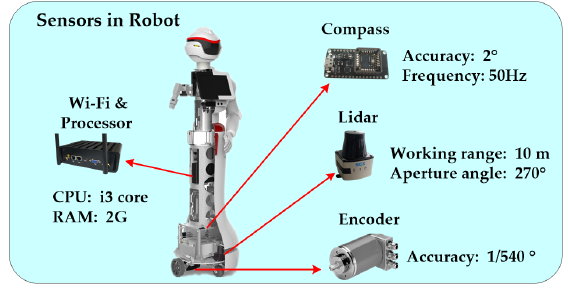
Figure 1. Sensors in the